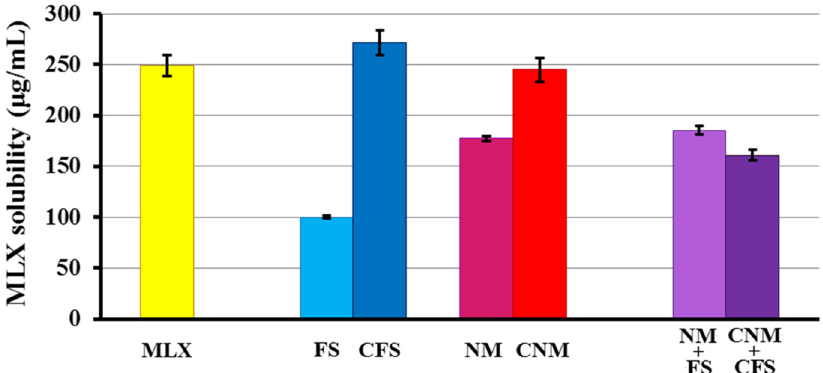
Figure 3. Solubility study of MLX raw material, and multiparticulate colonic systems: FS, NM, NM + FS, CFS, CNM and CNM + CFS in phosphate buffer (pH 6.8).